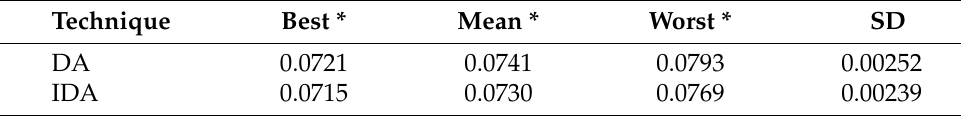
Table 2. DA and IDA results comparison.